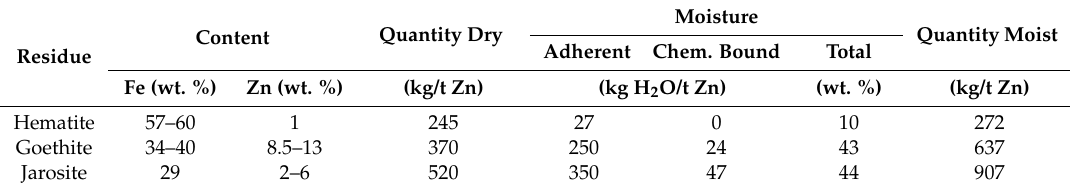
Table 1. Iron precipitation residues and their characteristics [4,5].